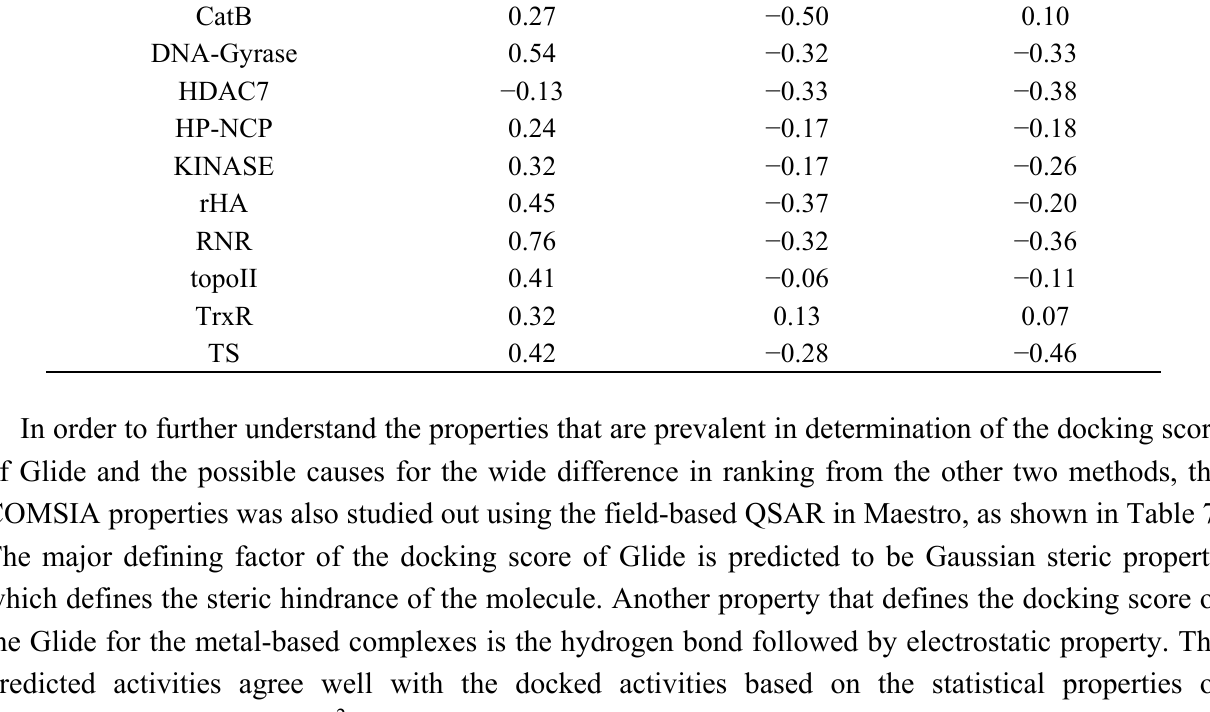
Table 6. The correlation of the docking results using the Autodock, Gold and Glide packages. Autodock vs . Gold Autodock vs. Glide Gold vs . Glide